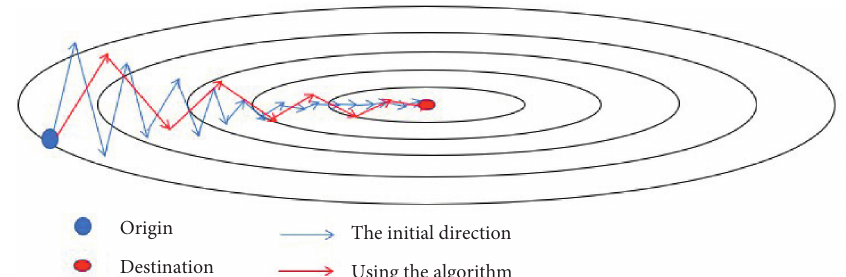
Figure 9: Optimization of neural network.